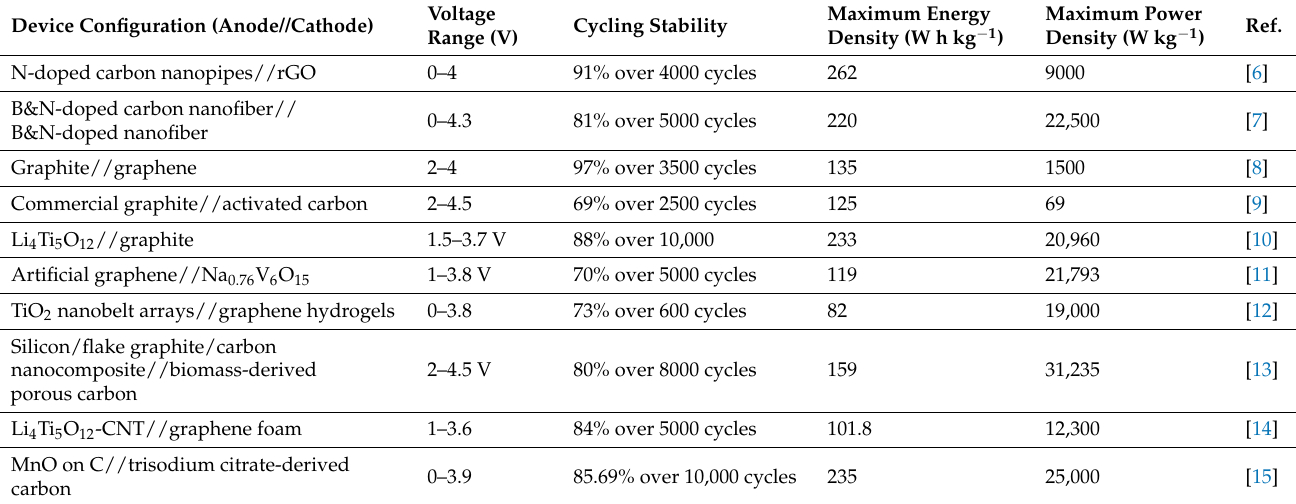
Table 1. Summary of energy/power densities of LIC electrode.